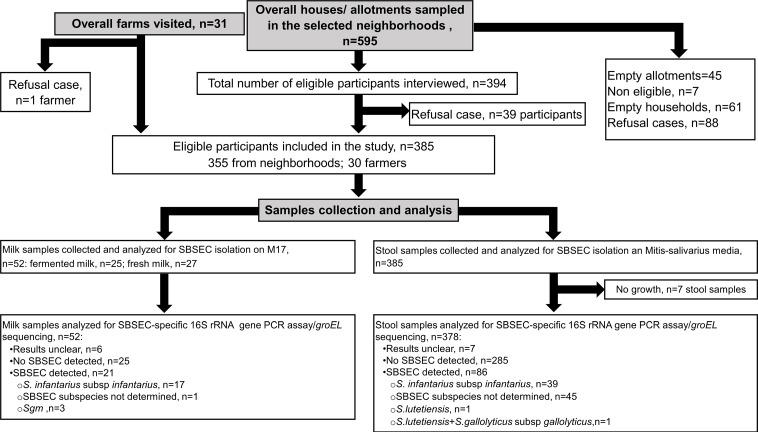
Data flow diagram of participant selection procedure and SBSEC/Sii detection from stool and milk sample analysis.